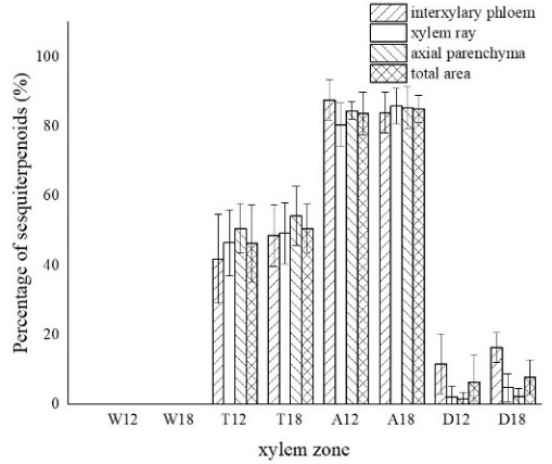
Figure 11. Color development statistics of sesquiterpenes in parenchyma cells of xylem of A. sinensis . W—white zone; T—transition zone; A—agarwood zone; D—decay zone; 12—inoculated for 12 months; 18—inoculated for 18 months.